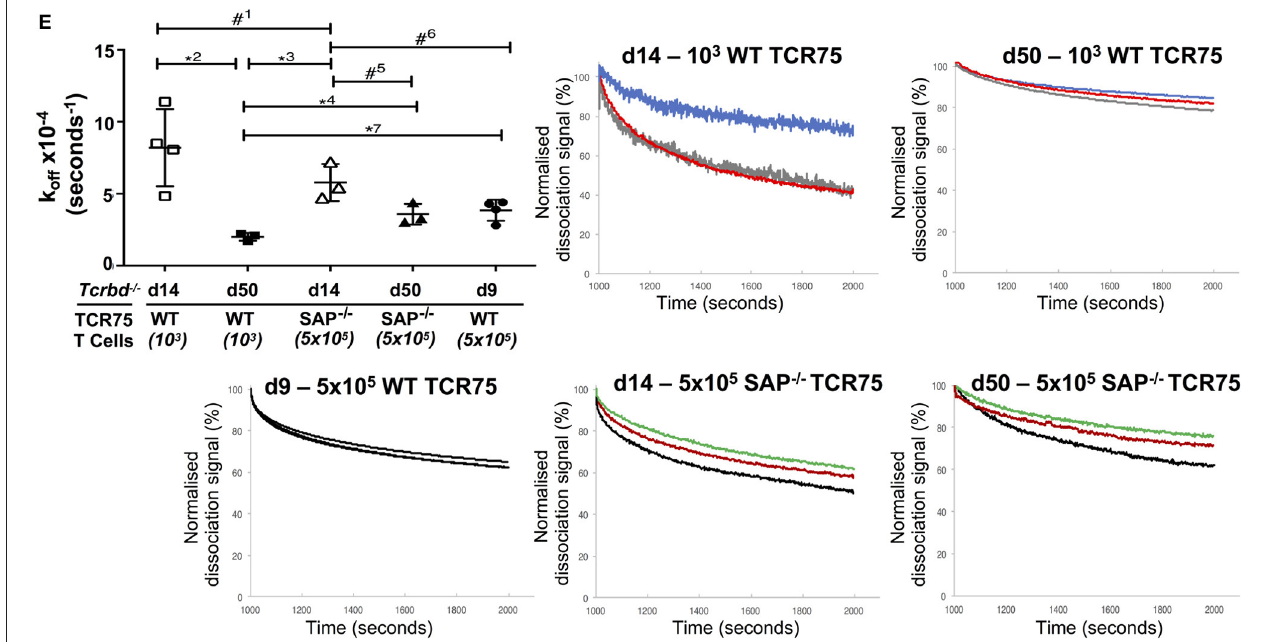
FIGURE 7 | Alloantibody mediates endothelial activation and proliferative vasculopathy. ( A) Representative photomicrograph of scratch-wound assay (left) and histogram (right) demonstrating enhanced migration of BALB/c endothelial cells (ECs) upon incubation with day 50 serum sampled from BL/6 Tcrbd − / − reconstituted with wild-type (WT) or SAP − / − TCR75 CD4T cells, whereas BL/6 EC migration was not above background (mean values, with each dot representing an average of six high power fields analyzed per biological replicate). Migration of BALB/c ECs in response to sera from d14 WT or d50 SAP − / − was significantly weaker compared to serum from d50 WT recipients; * P = 0.01 and ** P = 0.02, Mann–Whitney tests. (B) Quiescent BALB/c endothelial cells stimulated with media containing epidermal growth factor (EGF) or column-purified sera from: d50 non-reconstituted BL/6 Tcrbd − / − recipients of BALB/c grafts (negative control), d14 WT, d50 WT, d50 SAP − / − recipients, and pooled hyperimmune anti-H-2K d IgG serum (BALB/c skin grafts [SG] to BL/6 mice, positive control). Cell lysates were separated and immunoblotted with anti-Akt Ser473 , anti-phospho-Akt Ser473 , and GAPDH (control) mAb. Displayed Western blot represents three independent experiments. (C) Representative photomicrographs of coronary arteries from allografts explanted at day 50 and double immunolabeled with endothelial marker CD31 (green) and α -smooth muscle actin ( α -sm actin, red); scale bar − 200 µ m. Increased neointimal lesions in chronically rejecting BALB/c allografts containing a large number of α -actin–positive smooth muscle cells were observed in BL/6 Tcrbd − / − recipients reconstituted with 10 3 TCR75T cells ( middle column ) but not with SAP − / − TCR75 CD4T cells (right); Tcrbd − / − syngeneic grafts shown as comparison (left). (D) Representative photomicrographs of endomyocardial biopsies of human heart allografts in recipients with antibody-mediated rejection and double-immunostained with the endothelial marker CD31 (brown) and α -smooth muscle actin (red); magnification x25. Pronounced neointimal (NI) lesions, composed of dense smooth muscle cells (pink), lying between the media (M) and arterial lumen (L). Remnants of endothelial cell layer seen within neointima (arrows, right image). Images representative of staining patterns observed in three individual patients. (E) Ranking anti-H-2K d alloantibody dissociation kinetics. Left: dot plot histogram comparing anti-H-2K d alloantibody dissociation constants ( k off ) among BL/6 Tcrbd − / − recipients of BALB/c hearts reconstituted with either WT or SAP − / − TCR75 CD4T cells (at d9, 14, and 50 as depicted). Each value (mean ± SEM) represents the k off after global fit of two serum dilutions of the same biological replicate ( n = 3); # 1 P = 0.21, * 2 P = 0.01, * 3 P = 0.008, * 4 P = 0.02, # 5 P = 0.06, # 6 P = 0.05, # 7 P = 0.01; two-tailed Student’s t -test. Right : graphs depict sensograms of anti-H-2K d antibody dissociation rates in sera from BL/6 Tcrbd − / − recipients of BALB/c hearts reconstituted as shown, with each curve representing individual recipient mice. passive transfer of commercial anti-MHC class I alloantibody to T and B cell deficient recipients. We should, however, stress that the mechanisms by which the binding of alloantibody to allograft endothelium results in the neointimal proliferation and medial smooth muscle accumulations that typify allograft vasculopathy remain unclear, and will be the subject of ongoing